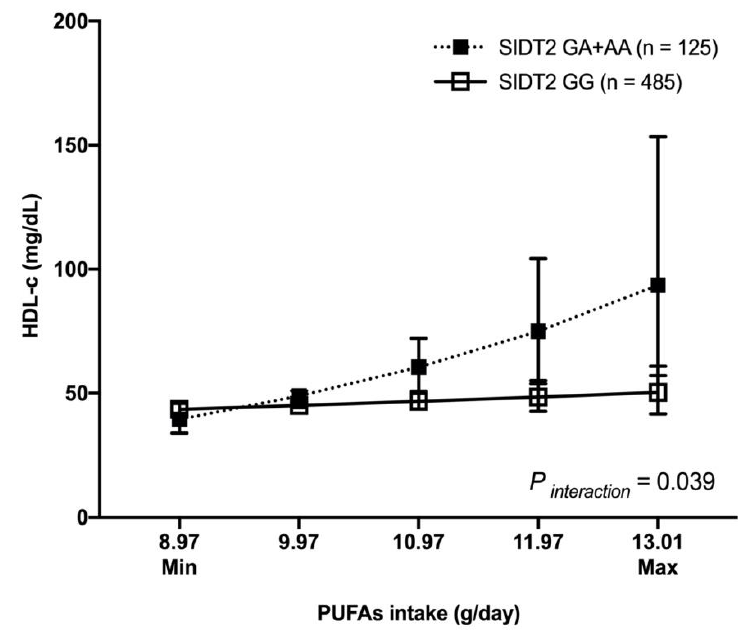
Figure 2. Interaction between SIDT2 -rs17120425 and PUFAs dietary intake with HDL-c levels in premenopausal women. HDL-c showed as mean, 95% confidence interval. PUFAs intake plotted as the minimum and maximum consumptions in the study population. Model adjusted for age (years), body mass index (Kg/m 2 ), physical activity (inactive/active), lipid-lowering medications (no, yes), smoking (no, current, past), diabetes (no, impaired glucose tolerance, yes), and arterial hypertension (SBP ≥ 140 or DBP ≥ 90 or antihypertensive drug); PUFAs: polyunsaturated fatty